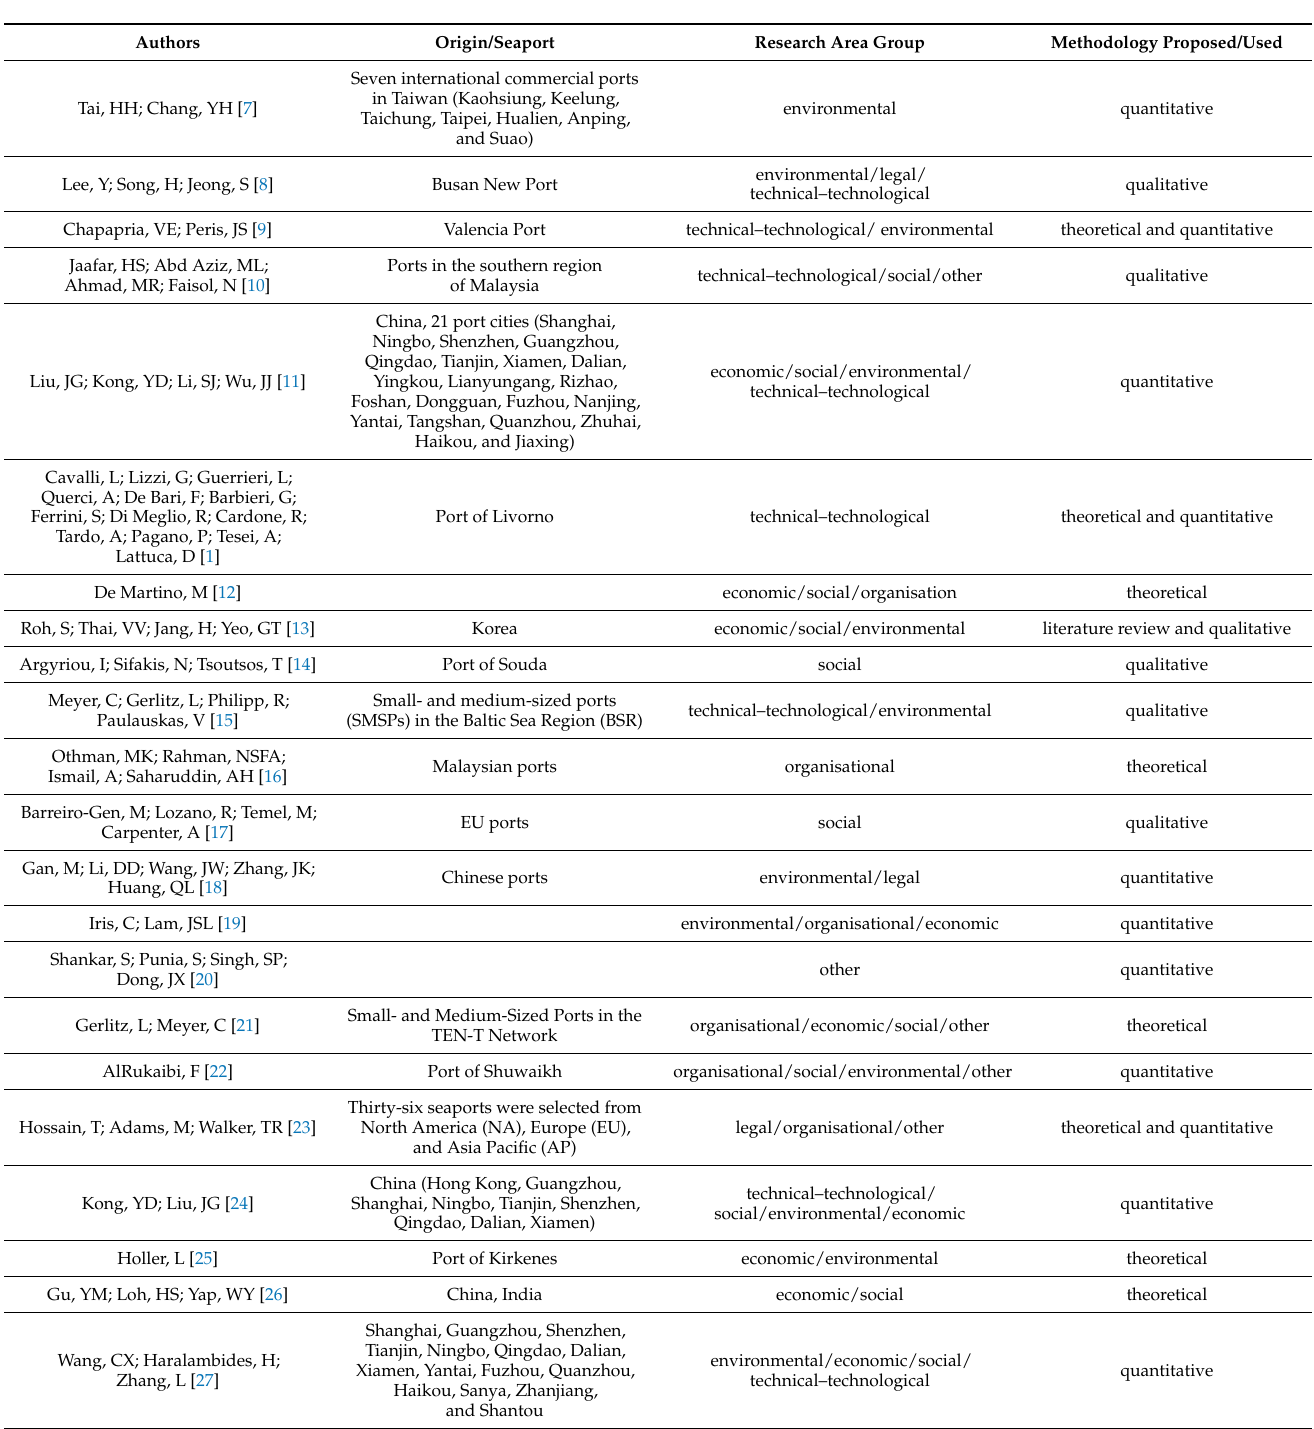
Table 1. Overview of publications that deal with sustainable